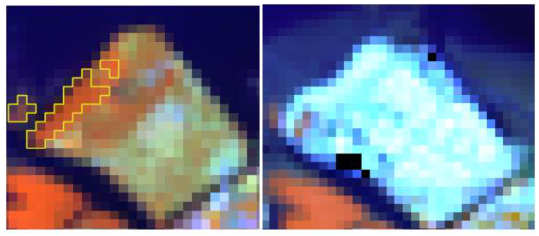
Figure 13. Construction in 2018 (left) and in 2020 (right).